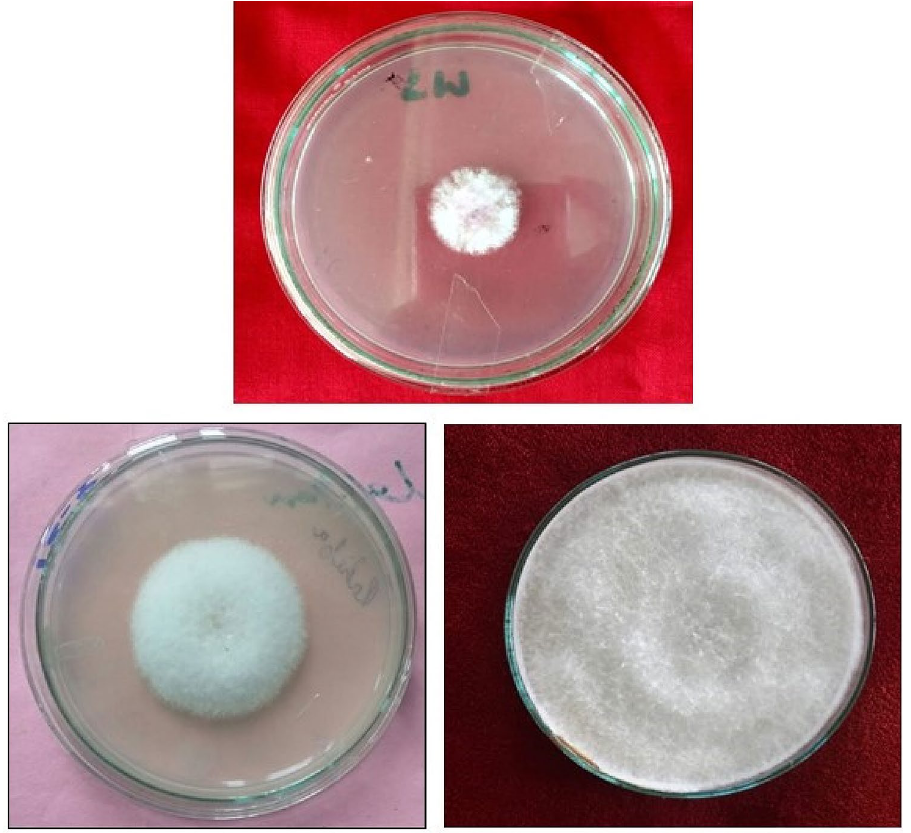
Figure 2. Isolation, purification and maintenance of the pathogen.